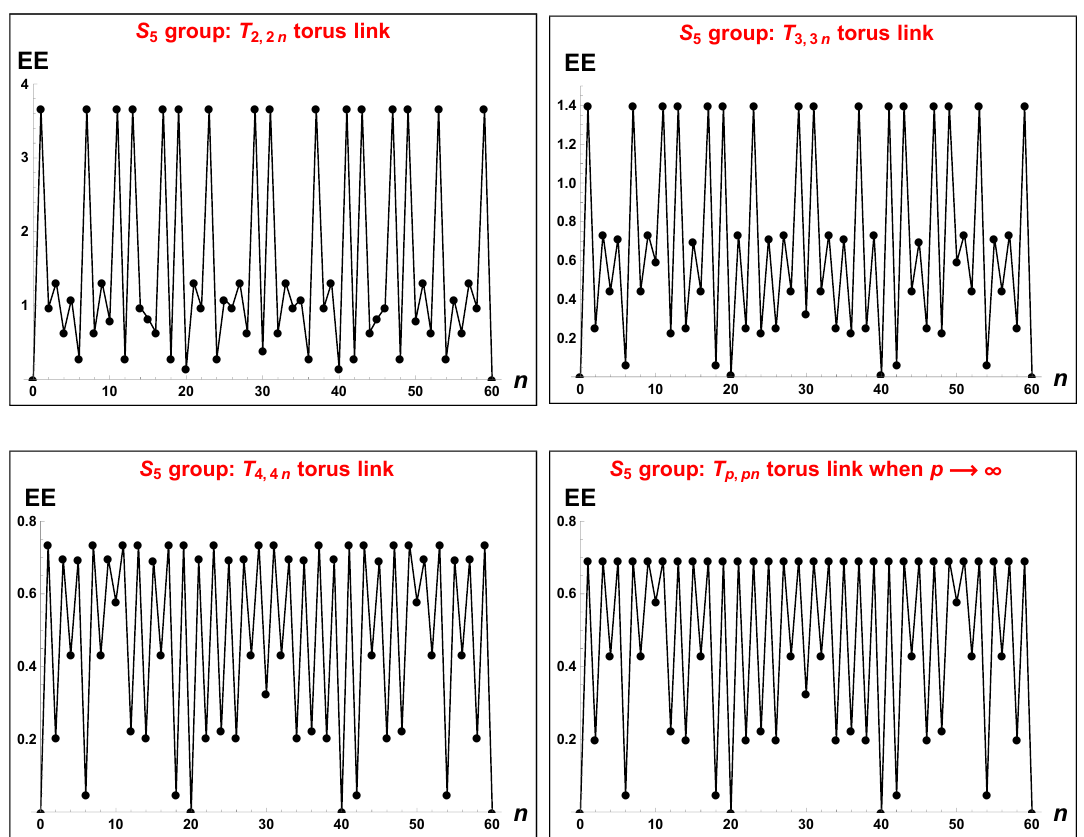
Figure 8 . The variation of entropy of j T p;pn i states computed for the S 5 group. The entropy (cid:13)uctuates as n increases and reaches maximum and minimum values according to eq. (4.55). We also show the entropy of j T p;pn i state as p ! 1 in the last